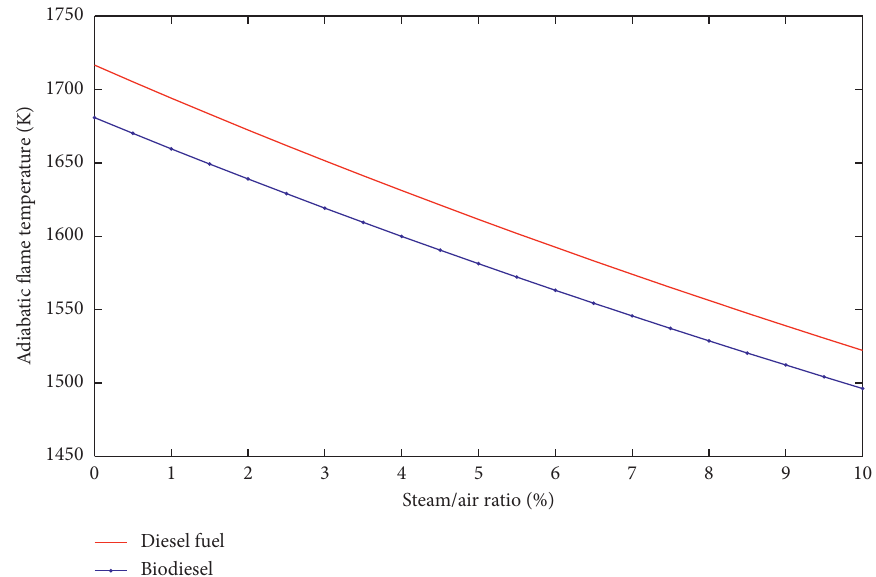
Figure 9: Adiabatic flame temperature comparison of biodiesel and diesel fuels at ϕ � 0.6.